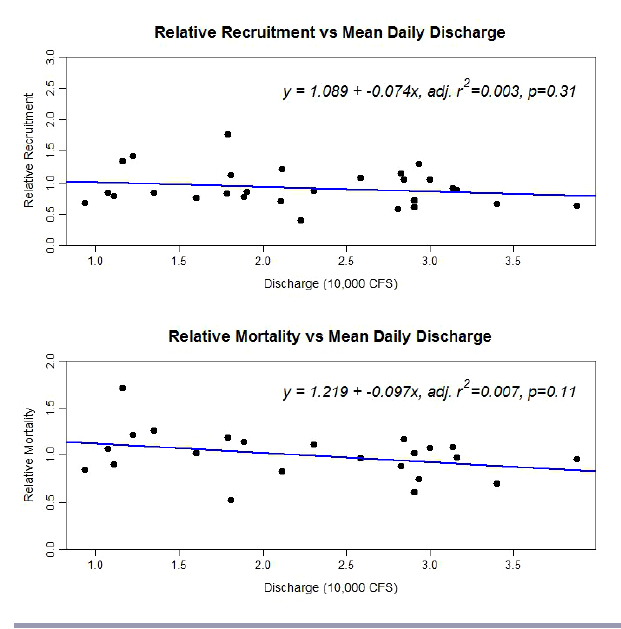
Fig. 6 . Relative monthly recruitment for 1990-2012 (top panel) and relative natural mortality rate (M) for 1990-2012 (bottom panel) versus average monthly Apalachicola River discharge (Q) measured at the U.S. Geological Survey Sumatra gauge